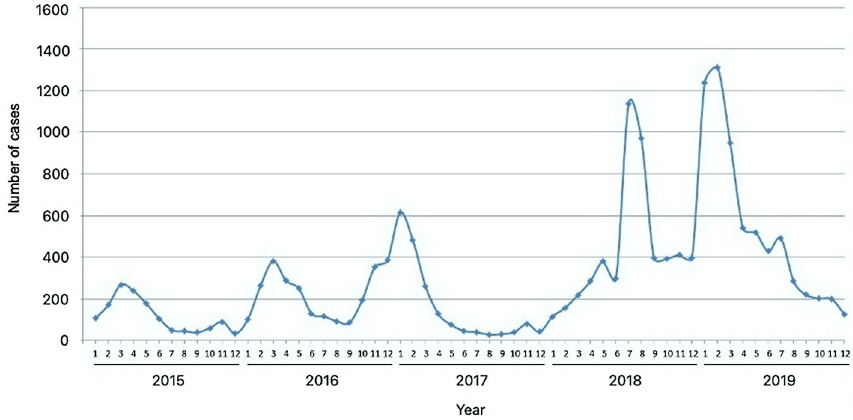
Figure 1. Monthly distribution of hand, foot, and mouth disease cases in Sabah from 2015 to 2019.